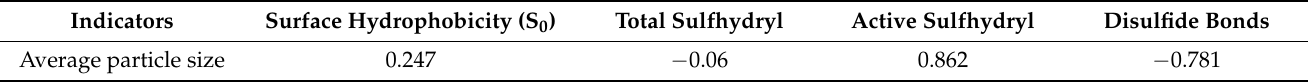
Table 2. Correlation analysis between protein aggregation behavior and particle